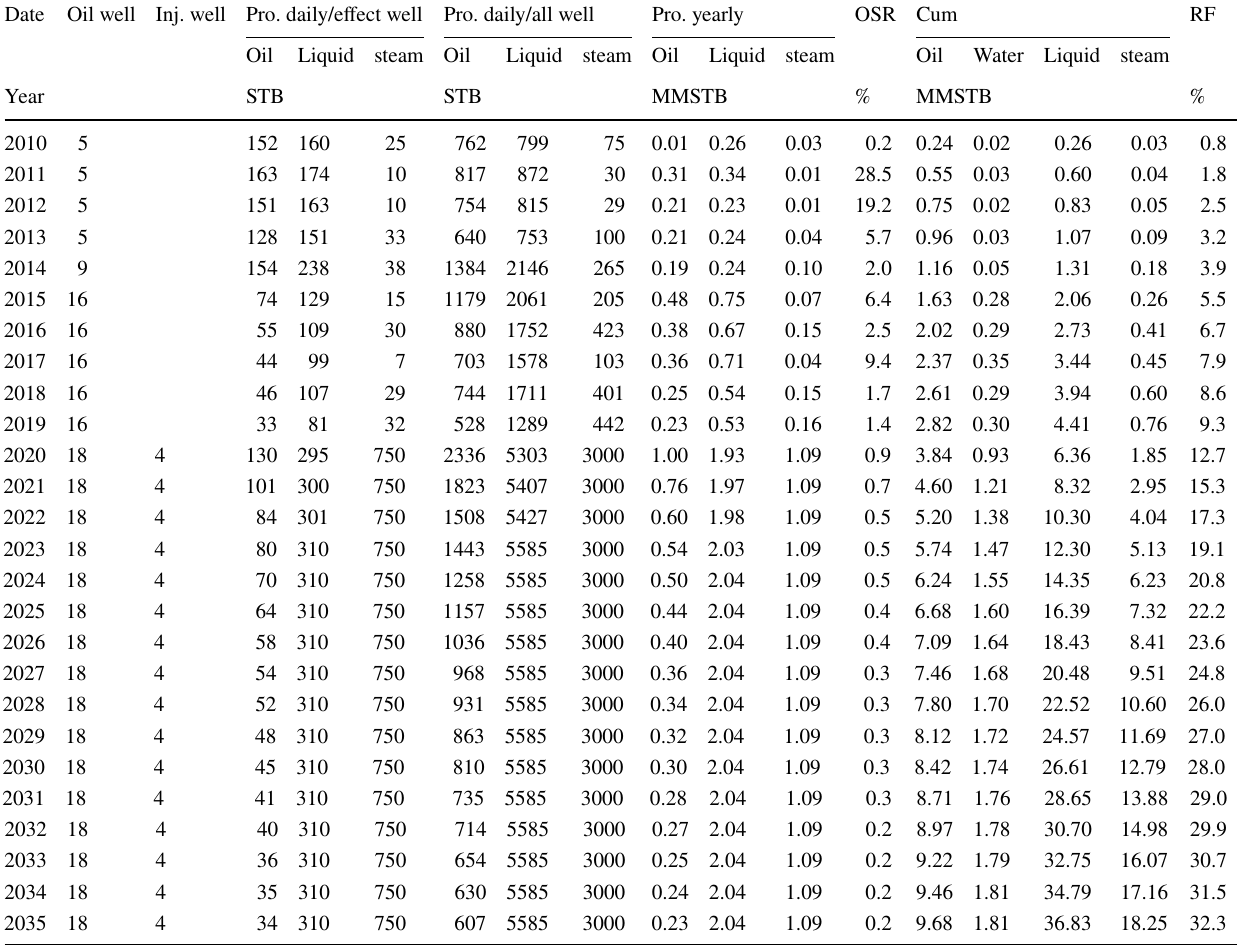
Table 19 Recommended case development indicator prediction Date Oil well Inj. well Pro. daily/effect well Pro. daily/all well